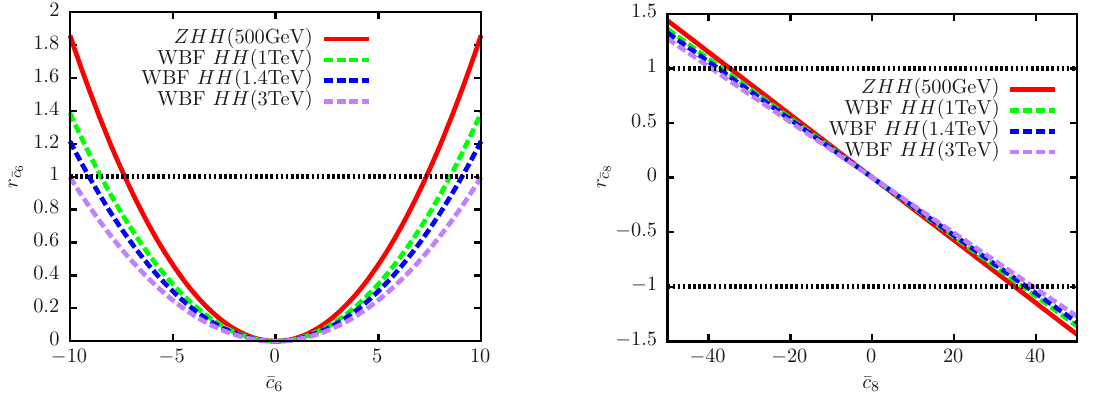
(left) and (cid:22) c 8 -dependence of r (cid:22) c 6